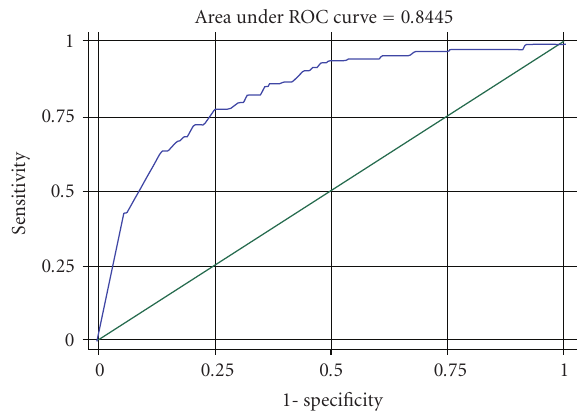
Figure 4: The sensitivity of DXL Calscan to predict hip fractures as a function of decreasing